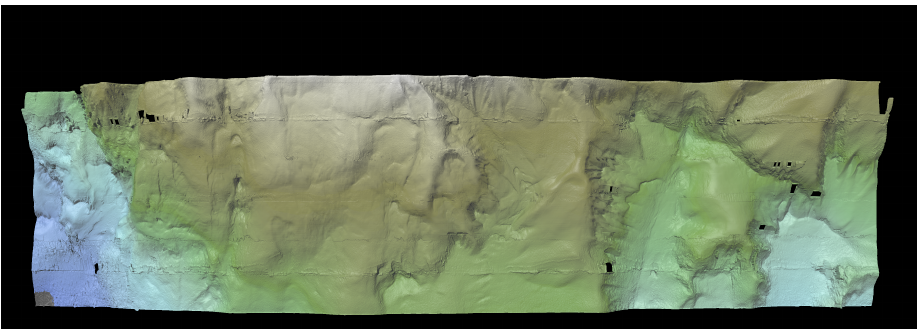
Figure 11. 3D shaded relief of the part of the mapped area at the depth range of 700–2300 m.